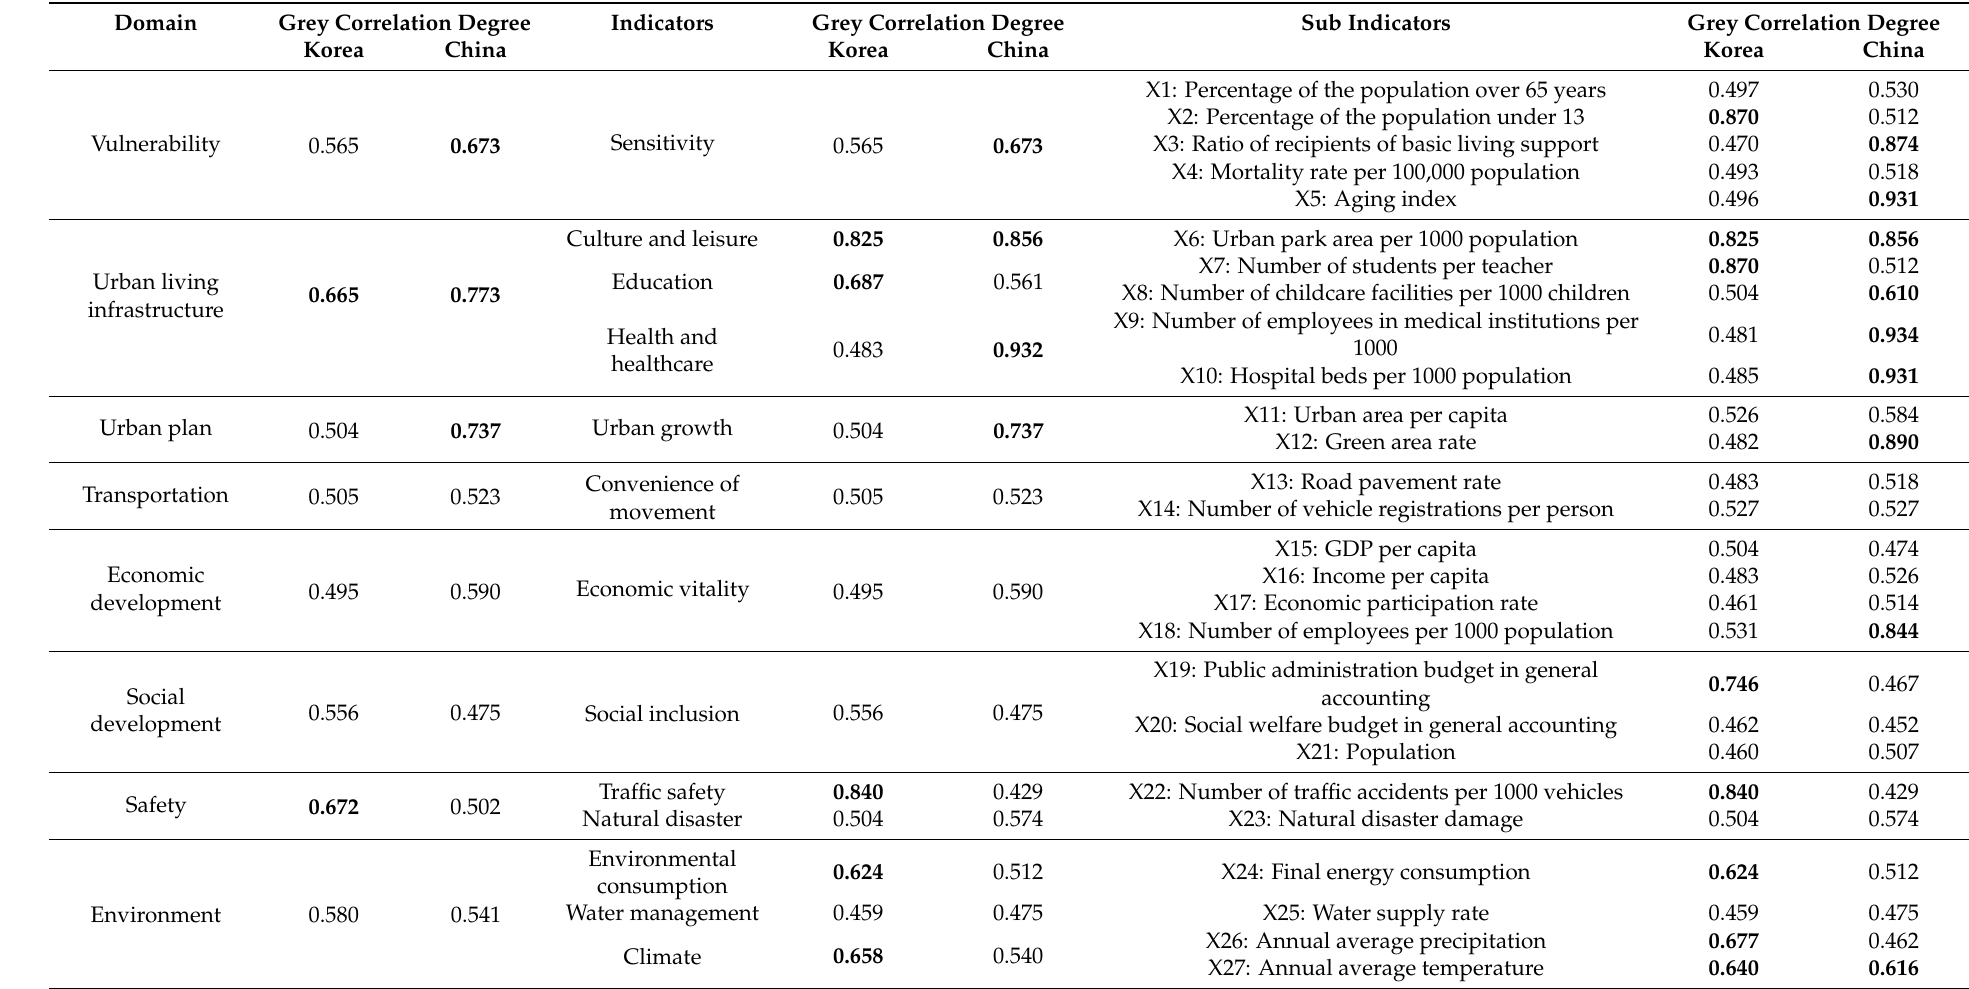
Table 2. Grey correlation degree results for the livability